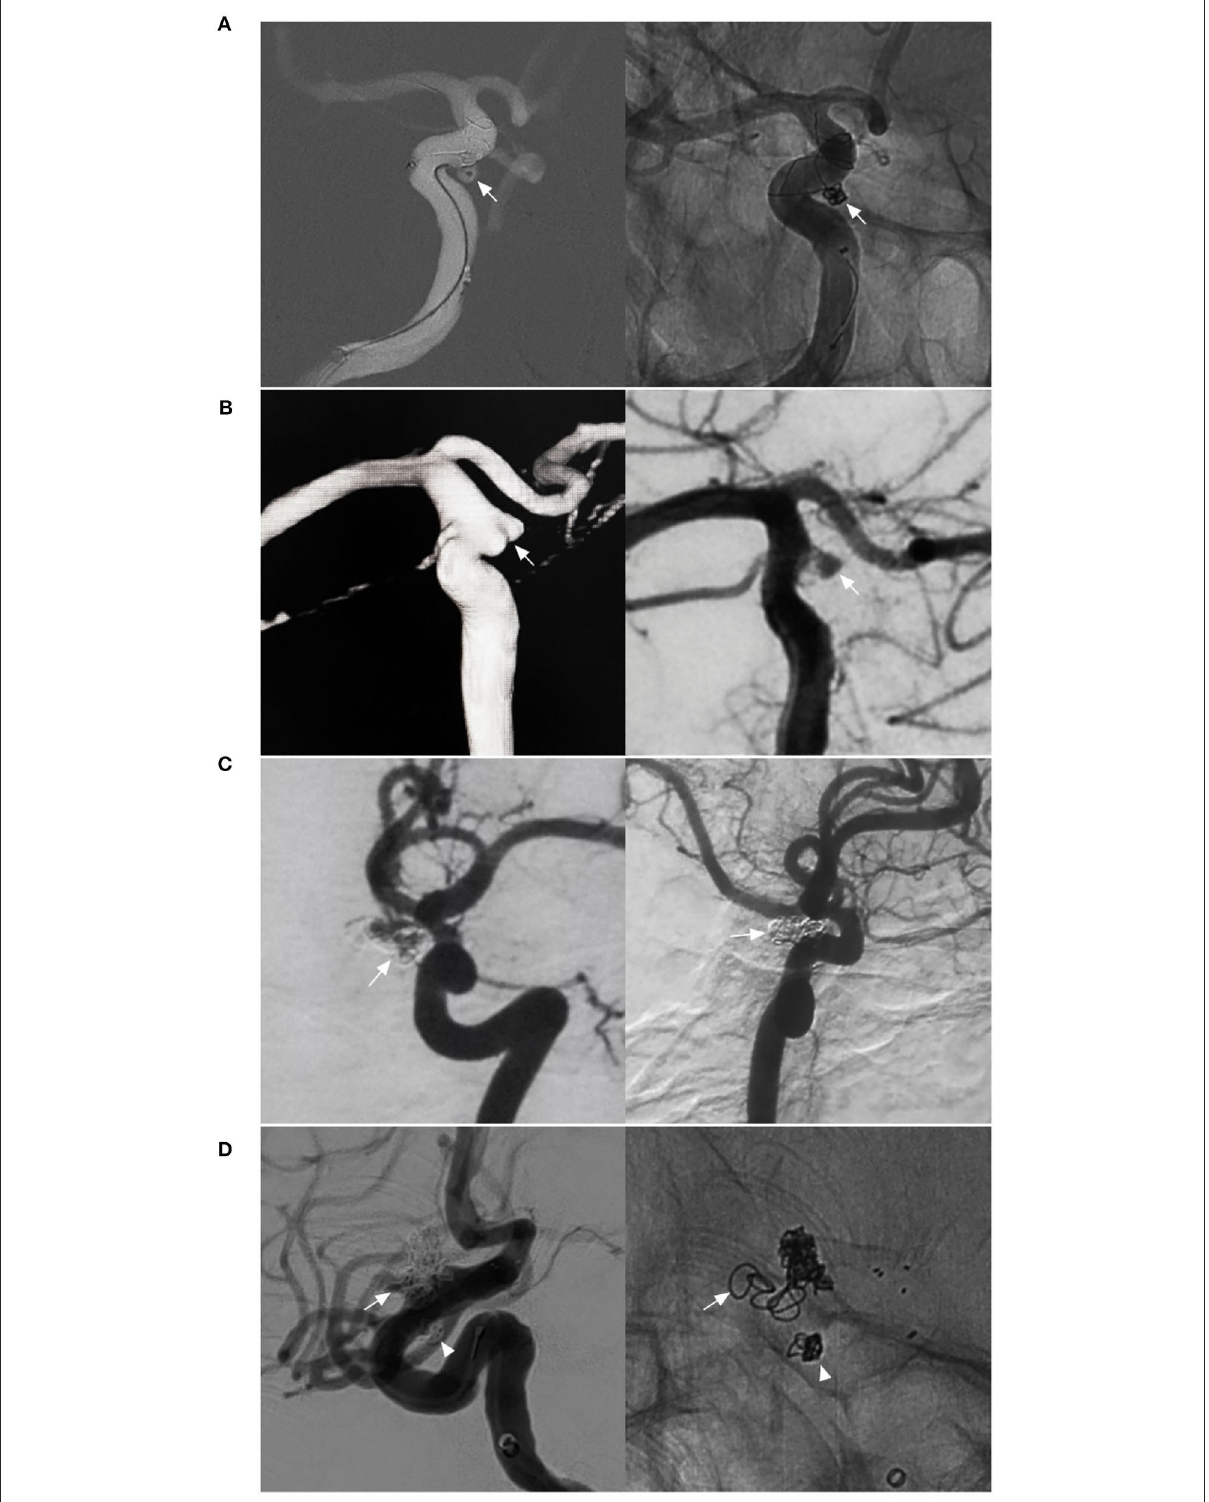
FIGURE6 EVT difficulty in aneurysms of the paraophthalmic segment. (A) Left, Road map navigation shows the microcatheter tip (arrow) positioned in the aneurysm sac with the assistance of stent semi-deployment. The stent sealed a part of the aneurysm neck and provided the opportunity for the microcrater to enter the aneurysm; right: unsubtracted DSA shows the coils in the aneurysm (arrow). (B) Left, three-dimensional DSA shows a wide-necked lobulated carotid cave aneurysm (arrow); right: DSA shows the loose packing of the coiling in the aneurysm because